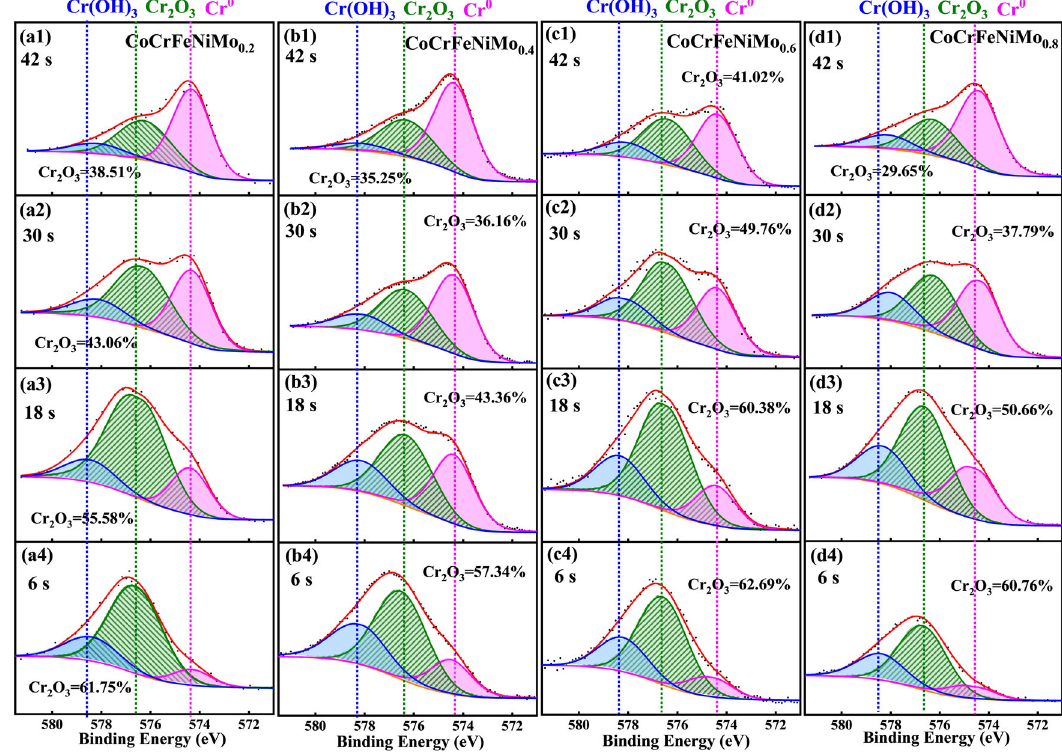
Fig. 11 The detailed XPS spectra of Cr 2p 3/2 of the passive fi lms. a Mo 0.2 , b Mo 0.4 , c Mo 0.6 , and d Mo 0.8 HEAs. Published in partnership with CSCP and USTB npj Materials Degradation (2022)